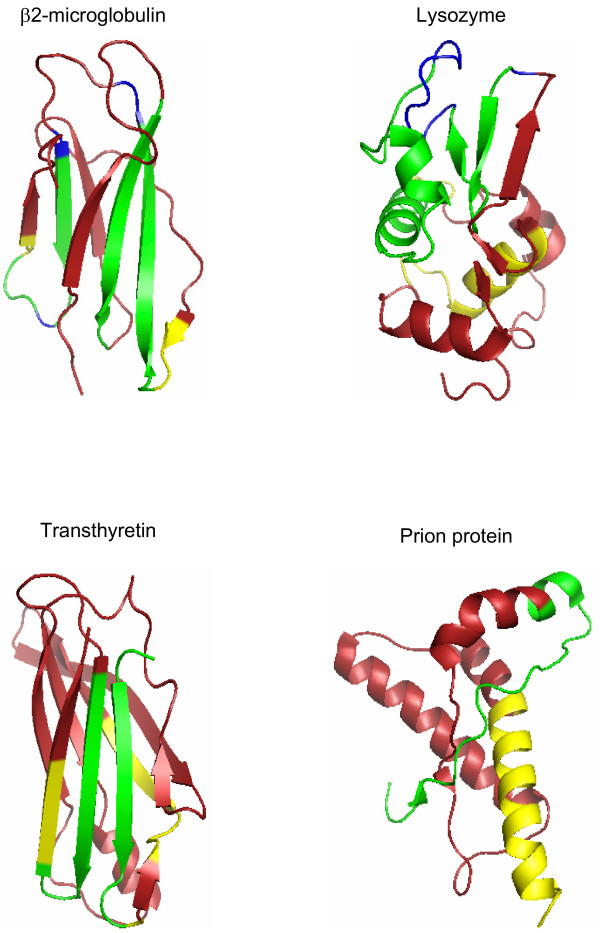
Representation of the 3D structure of globular proteins related to disease. The chain segments in which the prediction and the experimental data coincide are colored in green. Those identified experimentally to be relevant for amyloid formation but not predicted by the present approach are colored in blue. The regions predicted to be important for amyloid formation from which experimental data are not available or indicates that they are not involved in aggregation are shown in yellow.